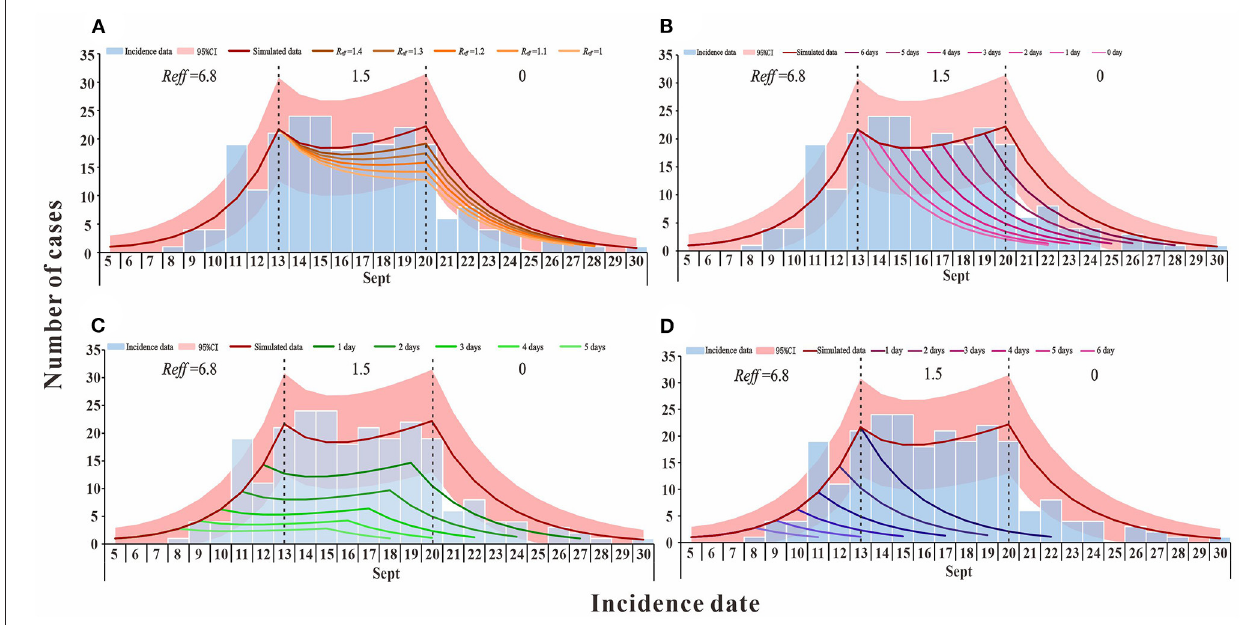
FIGURE 3 | The simulation results of comprehensive intervention measures in Xiamen City, China, 2021. (A) simulates the reduction of transmission capacity during the effective containment stage period of the epidemic; (B) simulates the decrease in the duration of the epidemic effective containment stage; (C) is the scenario simulating the advance of the peak time of the epidemic; and (D) simulates the situation where the peak time of the epidemic is advanced and there is no effective containment